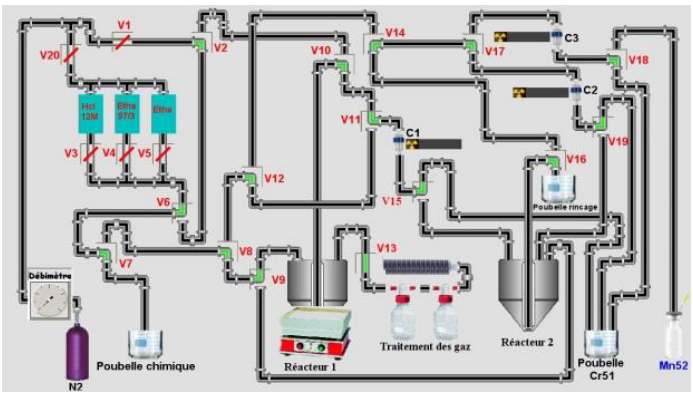
Figure 18. Remote control of Mn/Cr separation.